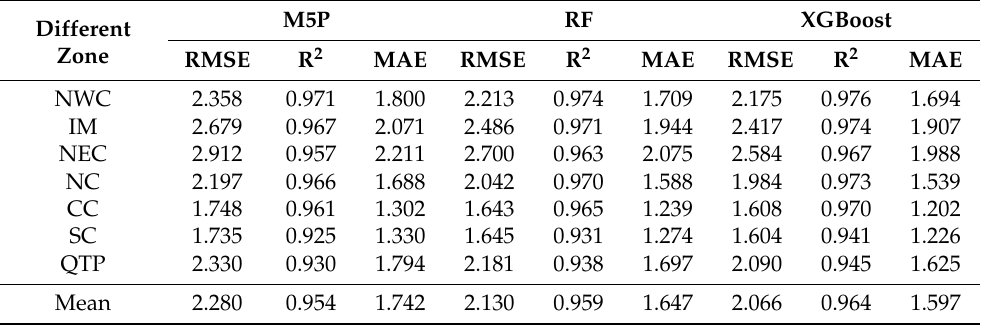
Table 2. Summary of the performance of data-driven models for soil temperature in different climate zones of